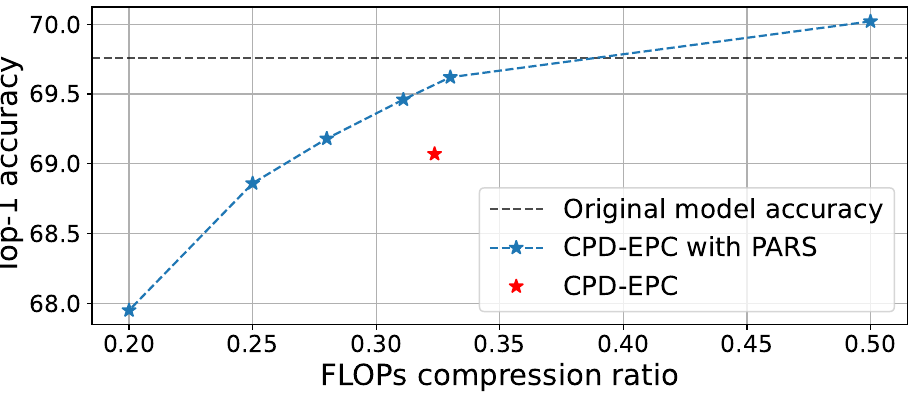
Figure 1. Top-1 accuracy vs. FLOP compression ratio on the ILSVRC-2012 dataset for the compres- sed ResNet-18